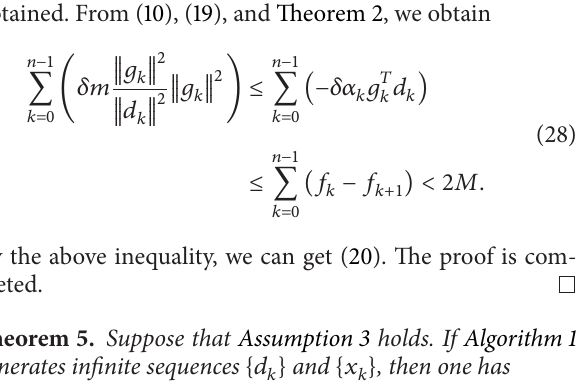
Table 1: The test